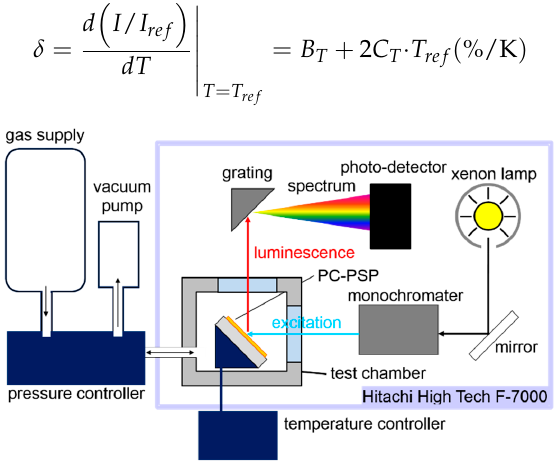
Figure 3. Schematic steady-state calibration setup.